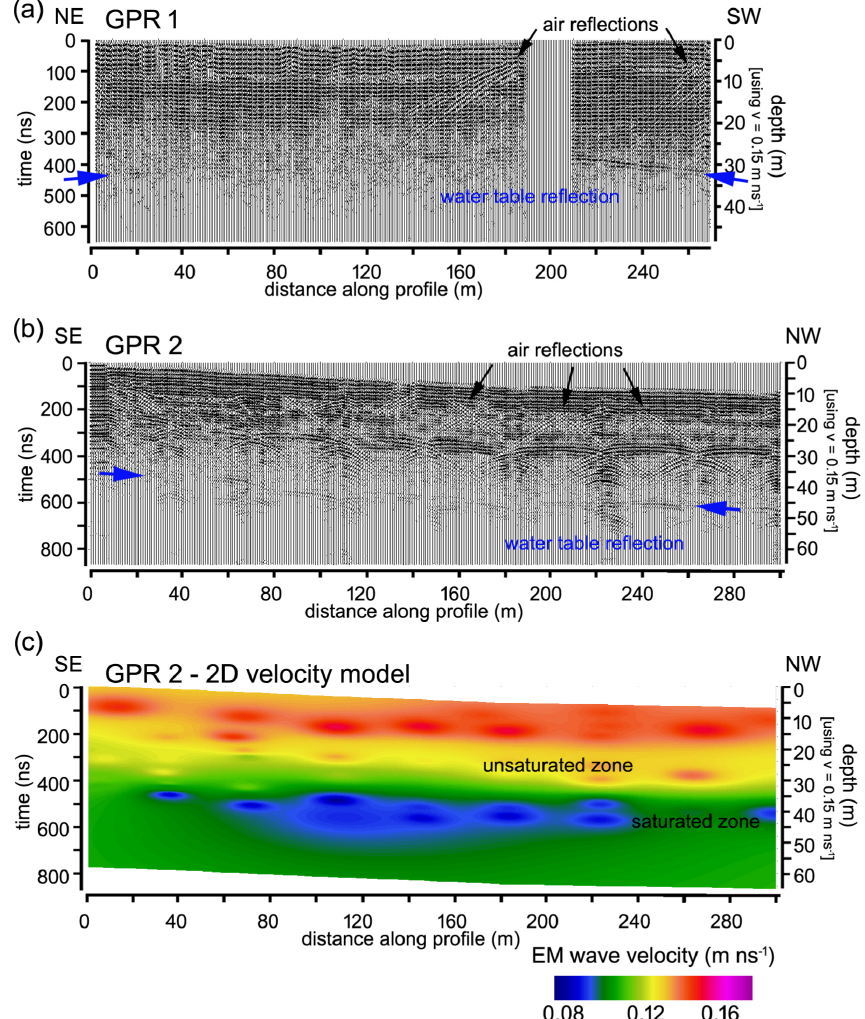
Figure 13. Water table estimation from GPR. (a) GPR profile 1 running NE–SW parallel to ERT1 reveals a horizontal reflector between 400 and 500ns two-way travel time ( ∼ 30–34m depth below the surface). Note the gap between 190 and 210m which is due to a surface artificial concrete channel. (b) GPR profile 2 running NW–SE along line ERT2 revealing a similar reflector at around 500ns two-way travel time ( ∼ 38m depth below the surface). Note that GPR profiles have been topography corrected via linear interpolation only; i.e. the depression is not shown in GPR1. Characteristic reflections have been marked by arrows. (c) GPR profile 2 electromagnetic wave velocity distribution. A characteristic drop in wave velocity is seen at the interface between the saturated and unsaturated